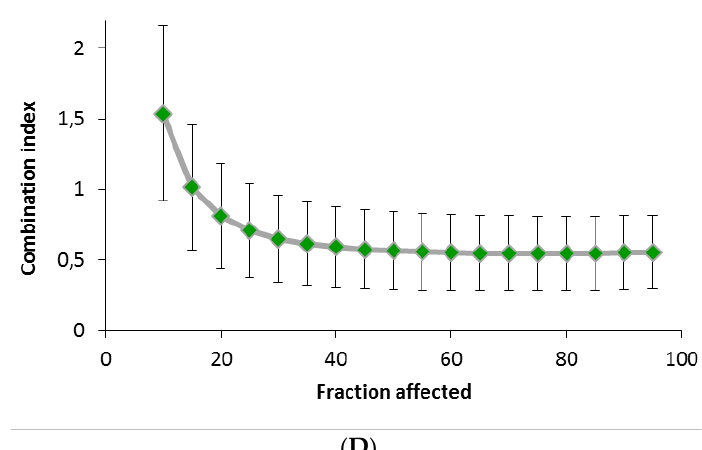
Figure 5. RM-581 blocks PC-3 cell proliferation. ( A ) Cytotoxic effects of RM-581 at 1 and 5 µM vs. a selection of current antineoplastic drugs. ** p < 0.01 vs. RM-581. ( B ) Effect of RM-581 and docetaxel on the proliferation of PC-3 cells at various concentrations (EC 50 of RM-581 = 1.2 µM). ( C ) Effect of RM-581 and docetaxel on the proliferation of docetaxel-resistant PC-3 cells at various concentrations (EC 50 of RM-581 = 0.9 µM). ( D ) RM-581 and docetaxel are synergistic anticancer agents in PC-3 cells. Combination index (CI) values were calculated using Chou–Talalay method [37]. Drug synergy, addition, and antagonism are defined by combination index (CI) values less than 1.0, equal to 1.0, or greater than 1.0, respectively. Two experiments were performed in triplicate ± SD.